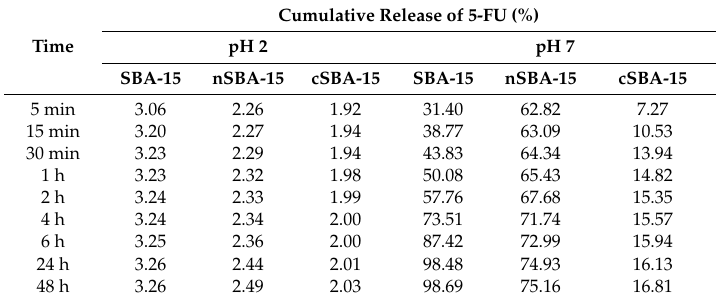
Table 3. Cumulative release of 5-FU from the samples in media with different